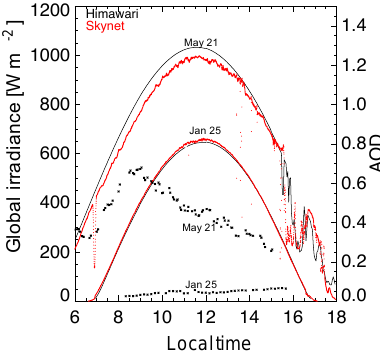
Figure 9. Global surface irradiance measured at the ground (red line) and estimated by Himawari-8 (black line) on 2 days (25 Jan- uary 2016 and 21 May 2016) mainly characterized by clear-sky conditions at the Chiba station. Measured SKYNET aerosol opti- cal depth (AOD) values are also shown for both days (black points, see opposite